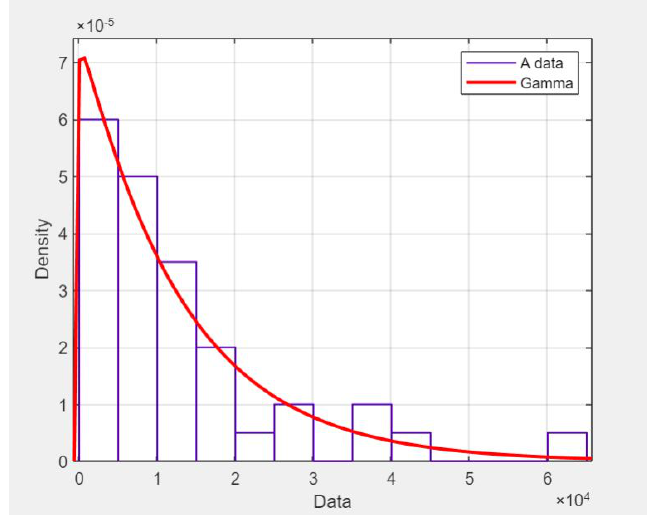
Figure 8. HISTFIT for group 1 in Category